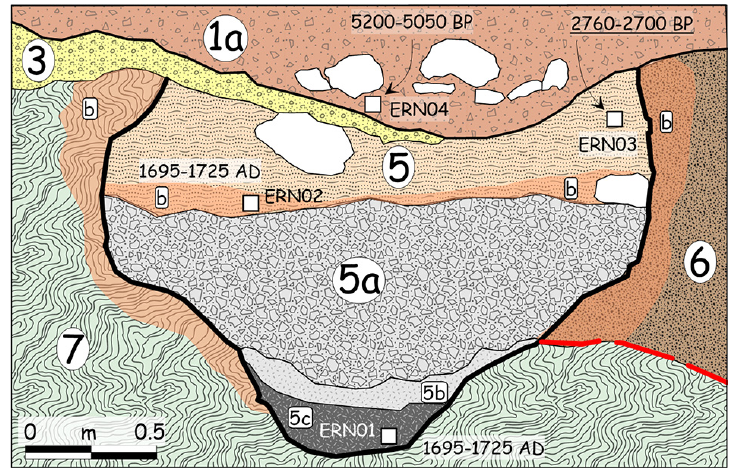
Figure 6. Sketch of the limekiln and 14 C ages of selected samples. Legend as in Figure 7. Outside the kiln (Figure 7), Unit 7 is the Cenozoic bedrock ( Scaglia variegata Formation, Eocene), made by tiny layered (5–10 cm) polychrome marls, strongly folded and truncated downhill by a subvertical fault plane paralleling the NW-SE trending outcrop. This fault is aligned with the aforementioned slickenside outcropping further SE (Figure 5). Unit 6 are brownish, layered, sandy colluvia, faulted against the fault plane and displaced also by a secondary splay by ~30 cm.